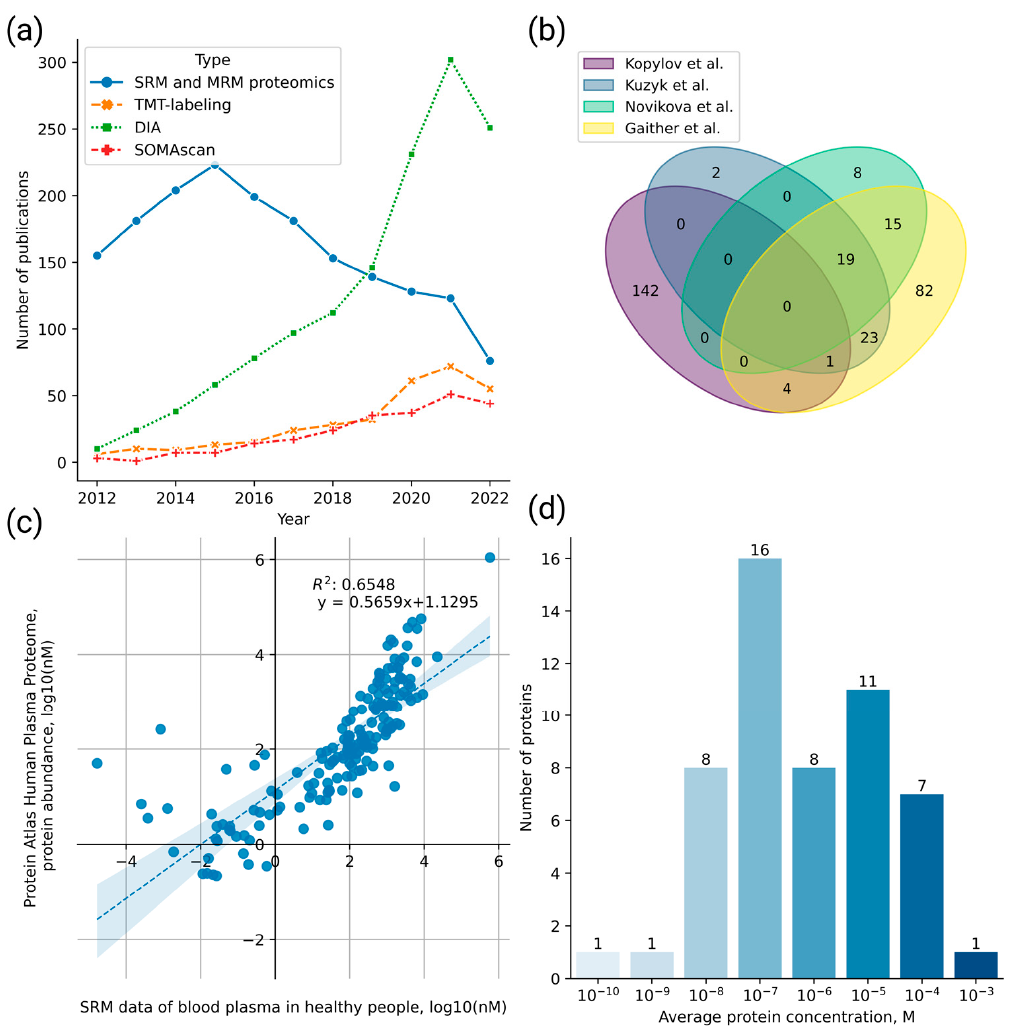
Figure 2. Meta-analysis of the SRM data for plasma from healthy volunteers. ( a ) Comparison of the number of published studies employing different proteomic methods in the PubMed database over the past ten years. A descending trend for selected and multiple reaction monitoring over the past years is highlighted in blue. ( b ) Venn diagram based on a comparison of the datasets obtained using the SRM method by Kopylov et al., Novikova et al., Kuzyk et al., and Gaither et al. [18,33,35,39]. ( c ) Correlation between protein concentrations (Log 10 (nM)) measured in the plasma of healthy volunteers using the SRM method in four studies [18,33,35,39] and concentrations of the same proteins reported in the Human Protein Atlas database. ( d ) Range of protein concentrations detected in more than 70% of samples and characterized by the interindividual coefficient of variation <40% obtained via a meta-analysis of studies [18,33,35,39].